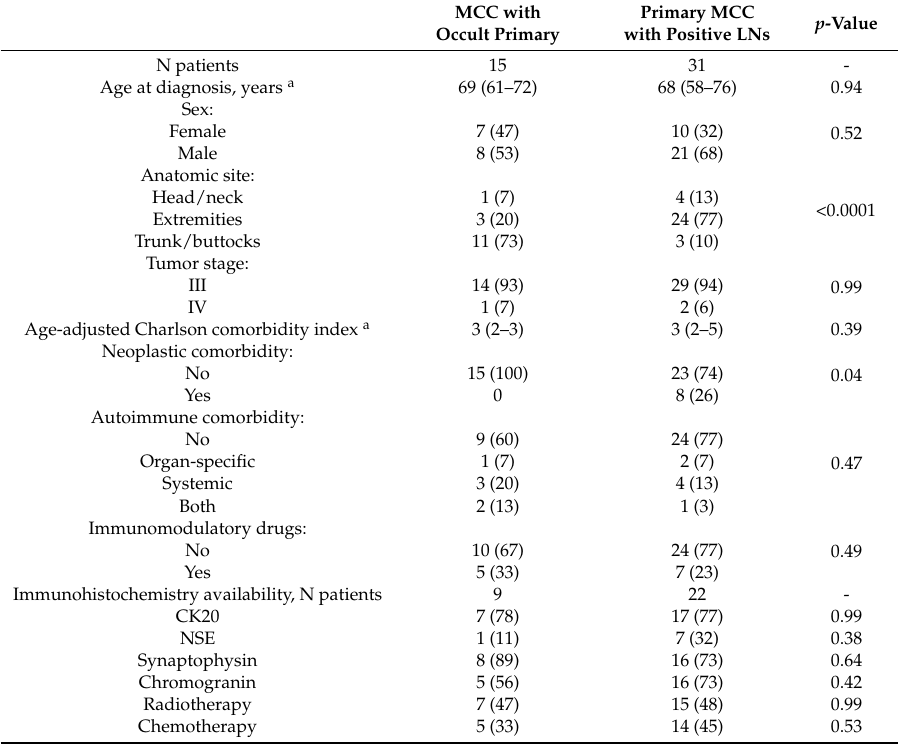
Table 4. Comparison of MCC with occult primary and primary MCC with positive